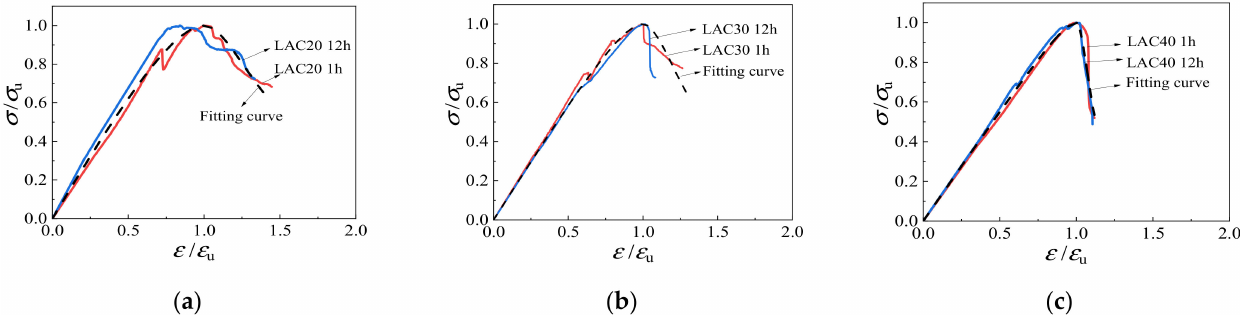
Figure 17. Comparison of uniaxial compression test curve and fitting curve. ( a ) LAC20, ( b ) LAC30, ( c )